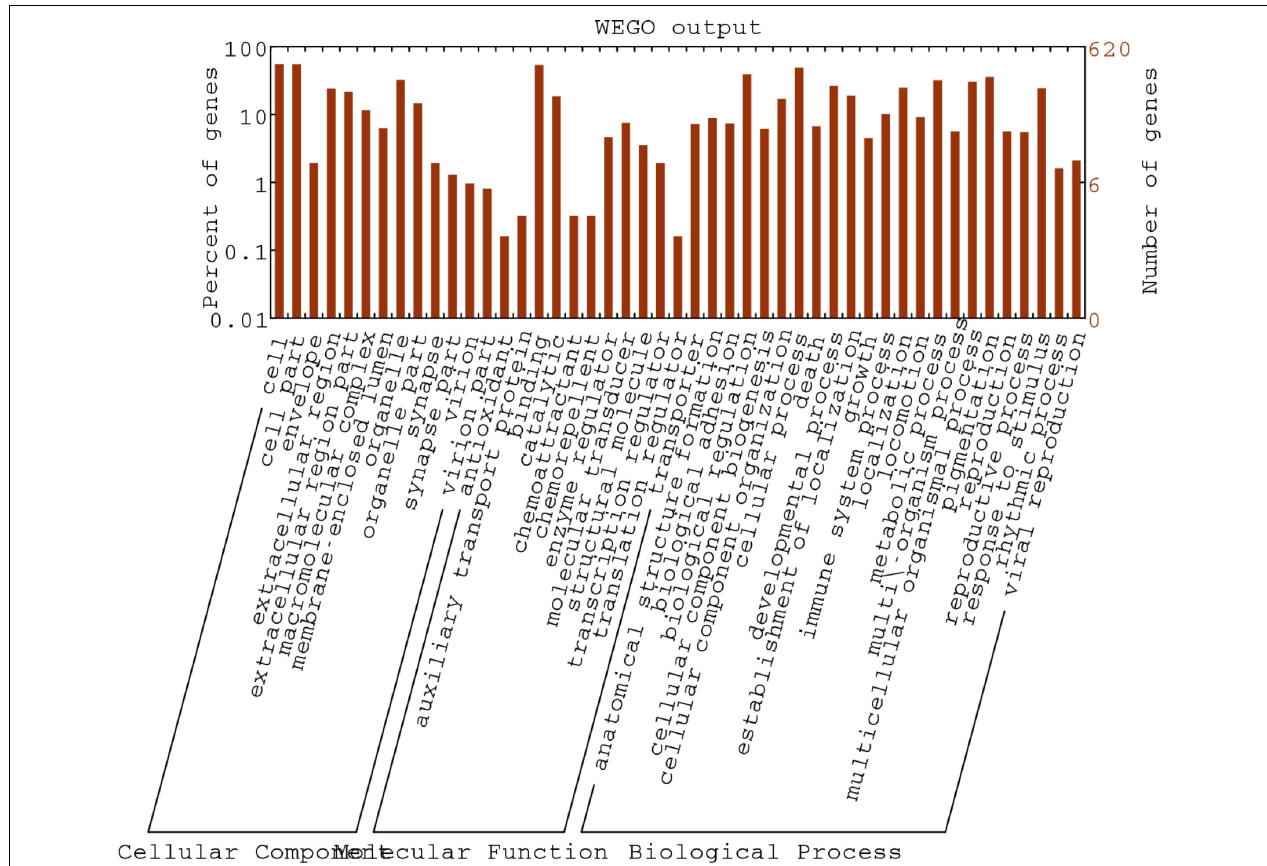
FIGURE 2 | Gene Ontology classification of assembled unigenes. The DEGs genes were classified into 3 functional categories: molecular function, biological process, and cellular component. The y-axis indicates the number of genes in a category. The x-axis indicates the specific category of genes in that main